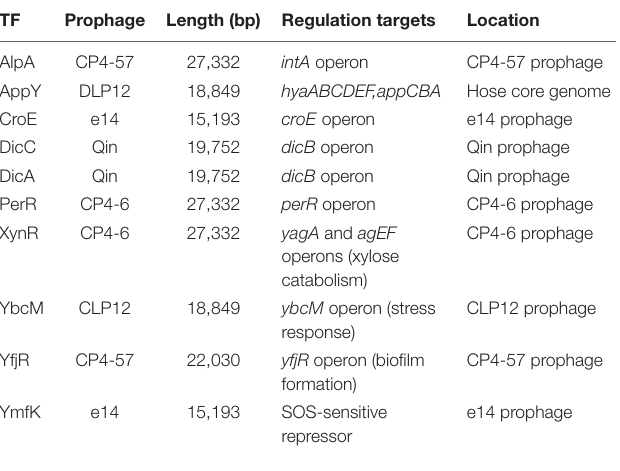
TABLE 2 | TF genes inside prophages in the E. coli K-12